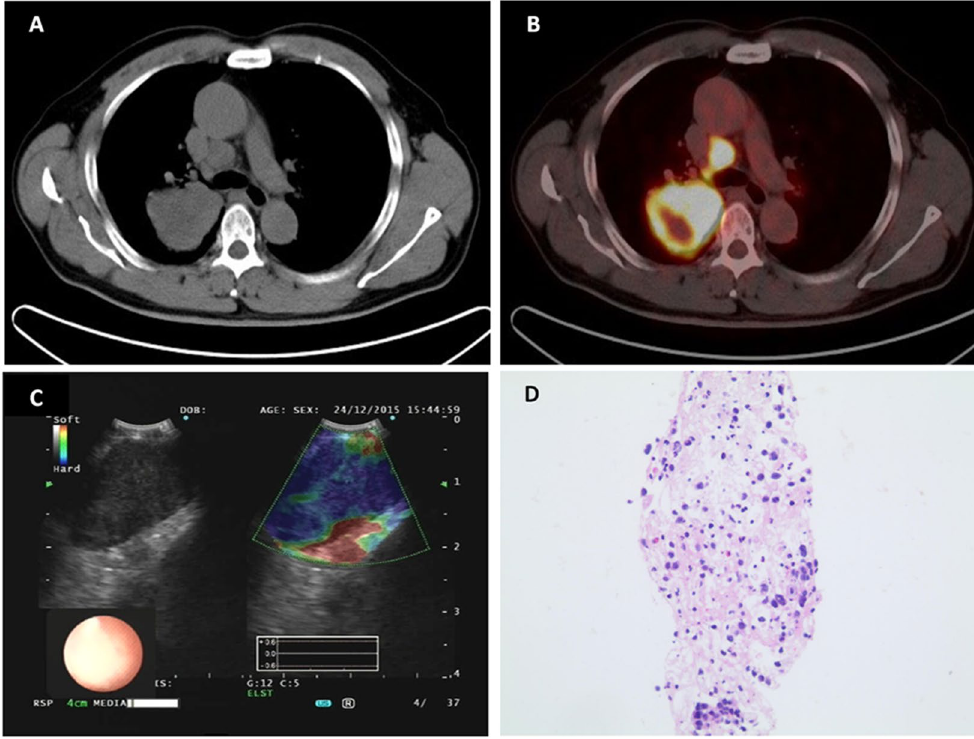
Figure 2. A representative case of BCP > 36.7% LN on EBUS elastography imaging. ( A ) A right lower paratracheal LN (#4 R) measuring 2.1 * 1.3 cm in diameter was shown on CT scan. ( B ) Significantly elevated FDG uptake in the right lower paratracheal LN (#4 R) was shown on FDG-PET/CT. ( C ) EBUS elastography imaging showed a predominantly blue (68%) area. ( D ) Histopathological diagnosis of EBUS-TBNA specimen was lung adenocarcinoma (hematoxylin–eosin stain, 200). LN, lymph node. Number of benign LNs/ Number of malignant LNs/ Elastography subtype total LNs number (%) total LNs number (%) BCP < 36.7% (n = 29) 26/29(89.7%)